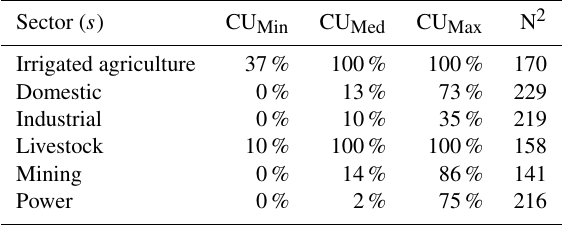
Table 1. Minimum, median, and maximum consumption use coef- ficients (CUs) used to estimate consumptive water use in NWED 1